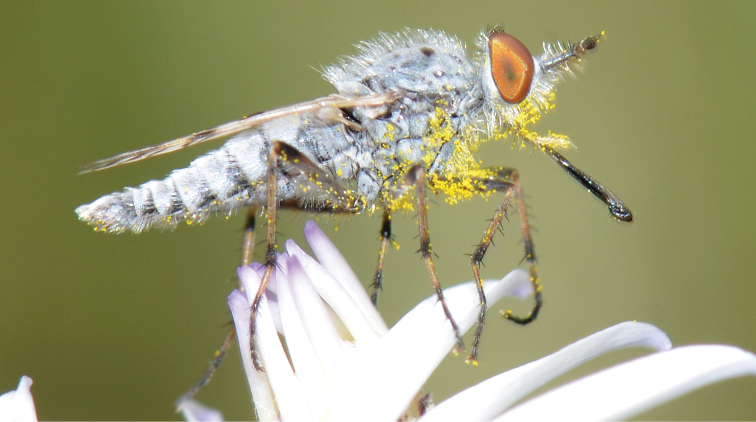
Medomega averyi sp. n., male, Western Australia, Stratton. Body length = 7.0 mm. Photograph credit: Fred and Jean Hort.